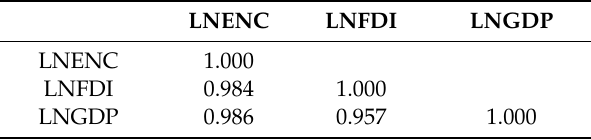
Table 4. Correlation matrix of variables.